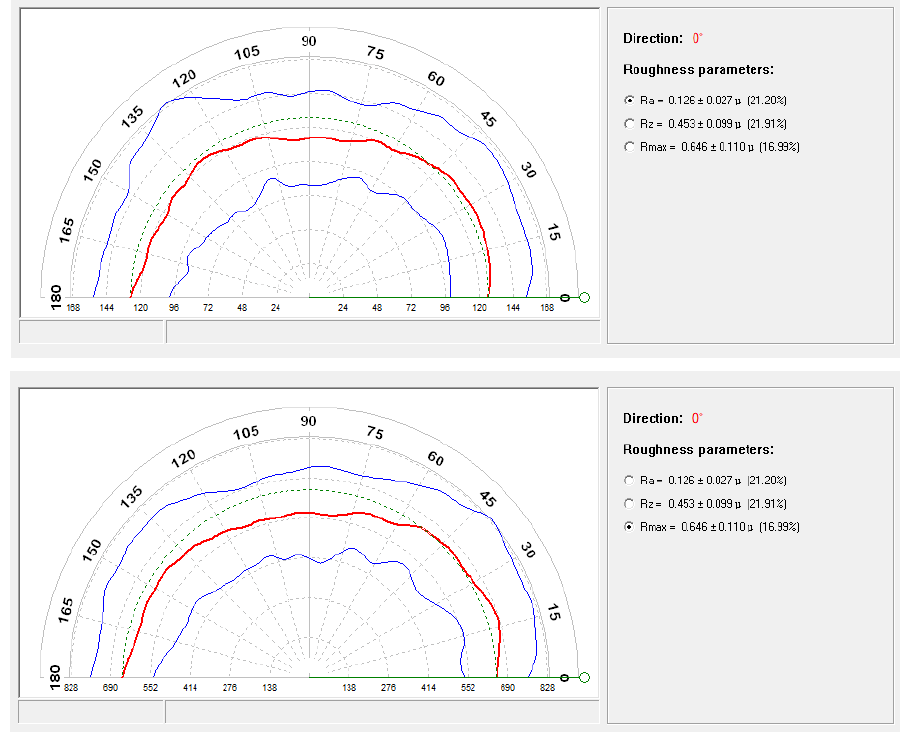
Fig. 2. Graph of displaying the dependence of the values of the roughness parameters on the azimuth angle in the XY plane On the graph, the red line shows the angular dependence of the average value of the selected roughness parameter, and the blue lines show the boundaries of the deviation of this parameter from its average value within the studied area of the